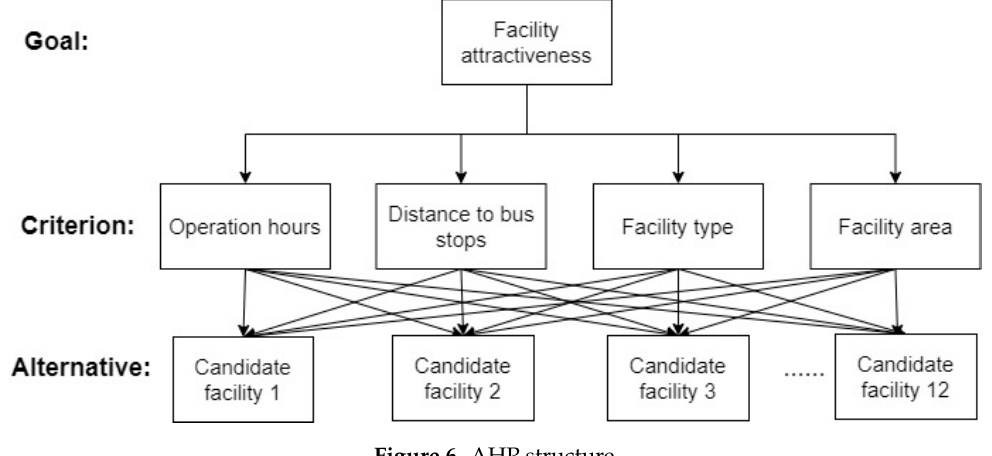
Figure 6. AHP structure.